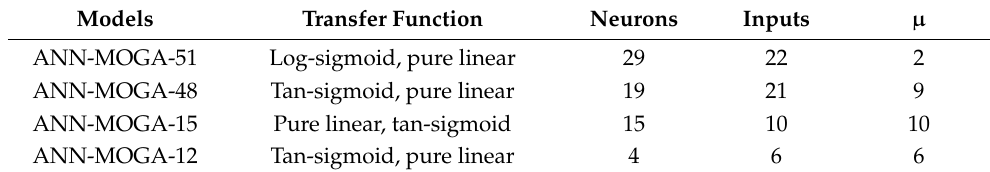
Table 4. Optimally selected parameters of ANN-MOG